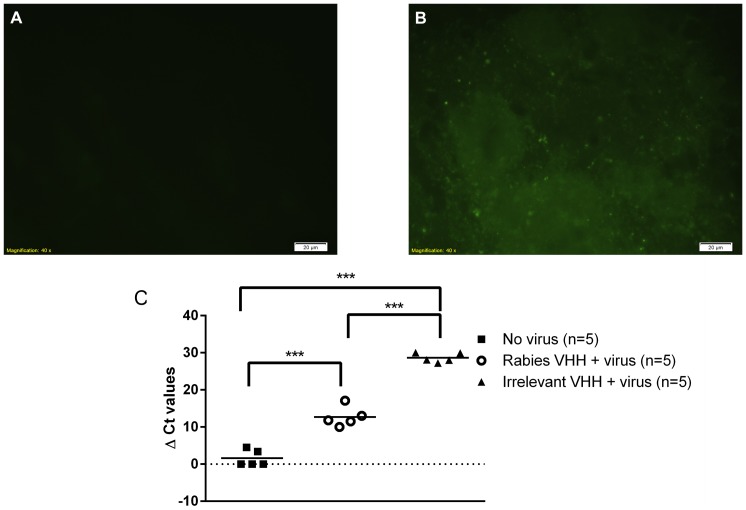
Co-administration of anti-rabies Rab-E8/H7 and virus directly in the brain efficiently inhibits virus infection.Mice were inoculated intracerebrally with a mix of rabies virus and 0.12 µg (1 IU) anti-rabies Rab-E8/H7 (A) or irrelevant VHH (B) and euthanized 7 days later. The anti-rabies VHH-treated mice were protected from disease, whereas all the mock-treated mice developed severe nervous disease. The pictures represent an immunofluorescence staining for viral nucleocapsid in the brain tissue. No viral antigens were visible in the brain of anti-rabies VHH-treated mice (A), whereas green fluorescent spots indicate the abundant spread of virus in the brain of mock-treated mice (B). The graph (C) presents the viral RNA load in the brains of different groups. Viral loads were significantly different between groups treated with Rab-E8/H7 and irrelevant control VHH, between Rab-E8/H7 and uninfected controls and between irrelevant control VHH and uninfected controls (*** p<0.01).